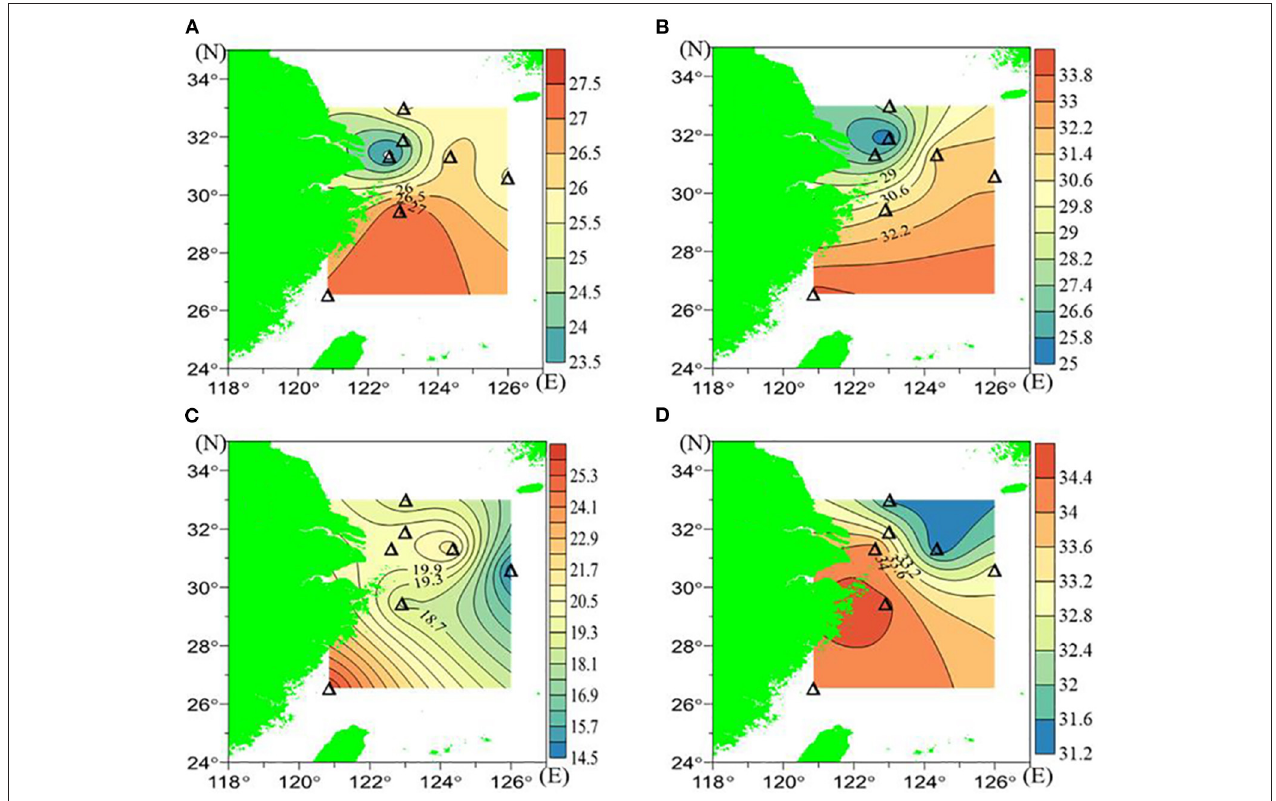
FIGURE 2 | The hydrological background in July 2018: (A) Surface temperature ( ◦ C), (B) surface salinity, (C) bottom temperature ( ◦ C), and (D) bottom salinity.